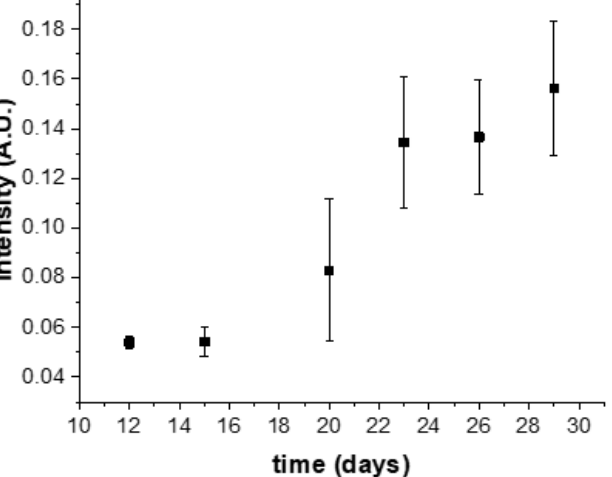
Figure 6. The intensity of light emitted by fluorescently labeled nanoparticles in A549 3D nodules over time with bars indicating standard error, n = 3. Cancer cells were periodically extracted from Matrigel by enzymatic matrix digestion and centrifugation, and the intensity of fluorophore absorption was measured in a plate reader. This absorption increased over time due to the time-dependent accumulation of GNPs in cancer